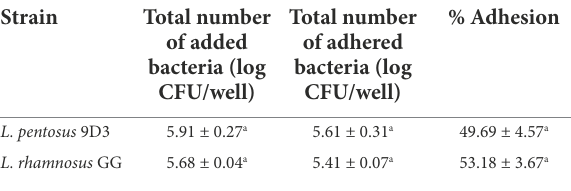
TABLE 5 Adhesion of L. pentosus 9D3 to Caco-2